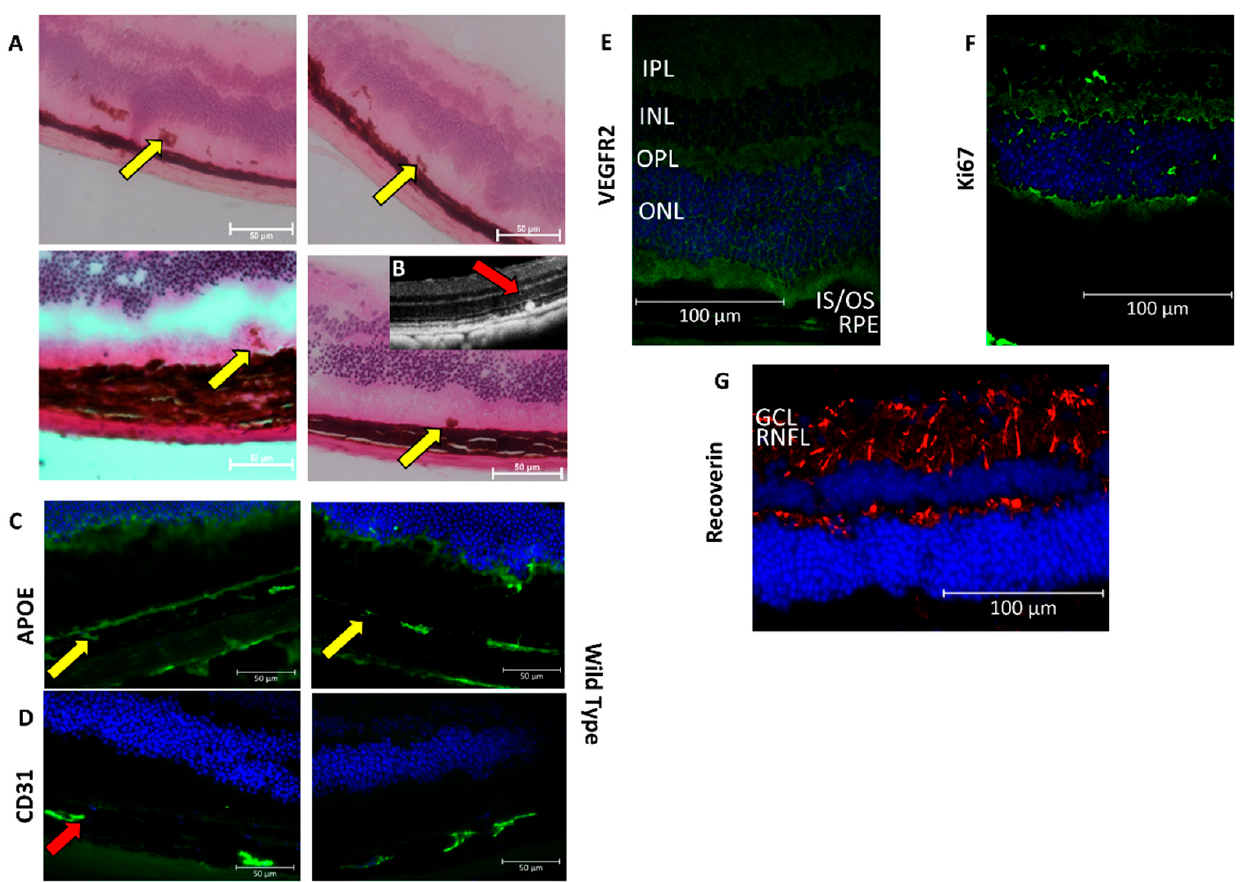
Figure 5. Immunohistochemical analysis of the retina from CAG-HtrA1 Tg mice vs. wild-type control (17 months). ( A ) Hematoxylin and eosin staining of the whole retina of CAG-HtrA1 Tg shows the flecked structures (yellow arrows) in the RPE layer denoting the presence of RPE migration in the retina. ( B ) RPE migration reflected in the OCT corresponding to the H&E stains ( C , D ) showing expression of ApoE (yellow arrows) in the RPE and CD31 in the retina and the choroid (red arrows) confirming that there is no significant difference between the CAG-HtrA1 Tg mice and wild-type mice groups. ( F ) Ki67, proliferation marker was not detected in CAG-HtrA1 Tg mice. ( E ) VEGFR2 and ( G ) Recoverin showed positive. Nuclei were stained with DAPI (blue). (Abbreviations: RNFL: retinal nerve fibre layer; GCL: ganglion cell layer; IPL: inner plexiform layer; INL: inner nuclear layer; OPL: outer plexiform layer; ONL: outer nuclear layer; IS/OS: inner and outer segment; and RPE: retinal pigment epithelium).